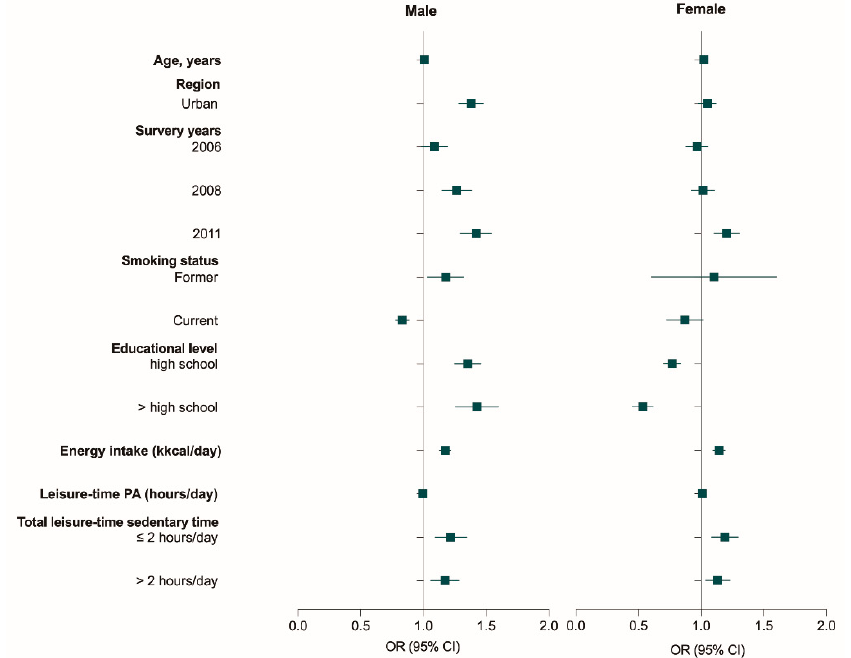
Figure 3. Association between total daily sedentary time and excessive weight among the Chinese population. Note: PA: physical activity; OR: odds ratio; CI: confidence interval; sex, energy intakes, physical activity, region (in urban and rural areas), survey year, educational level, and smoking status were adjusted. Reference for each categorical variable: region: rural; survey year: 2004; smoking status: current; education level: less than high school; total LT-SB time: less than or equal one hour per